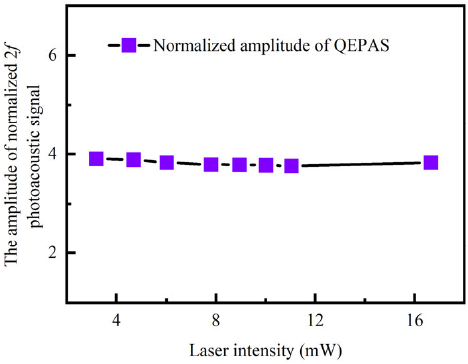
Figure 6. The amplitude of normalized the 2 f photoacoustic signal relative to light intensities.